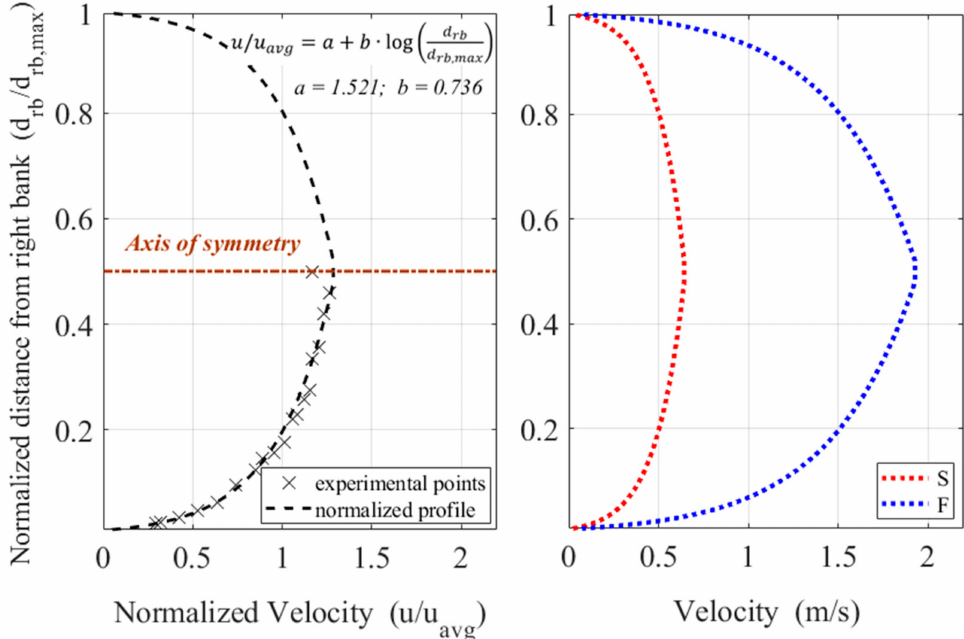
Figure 3. On the left panel, the normalized cross-section velocity profile, with indication about the experimental points from [42], the curve fitting equation for half section with parameters (a = 1.521 and b = 0.736) and the axis of symmetry. On the right panel, slow (S) and fast (F) velocity profiles, obtained multiplying the normalized profile by the average velocity u avg of 0.5 m/s and 1.5 m/s for the S- and the F-profile,